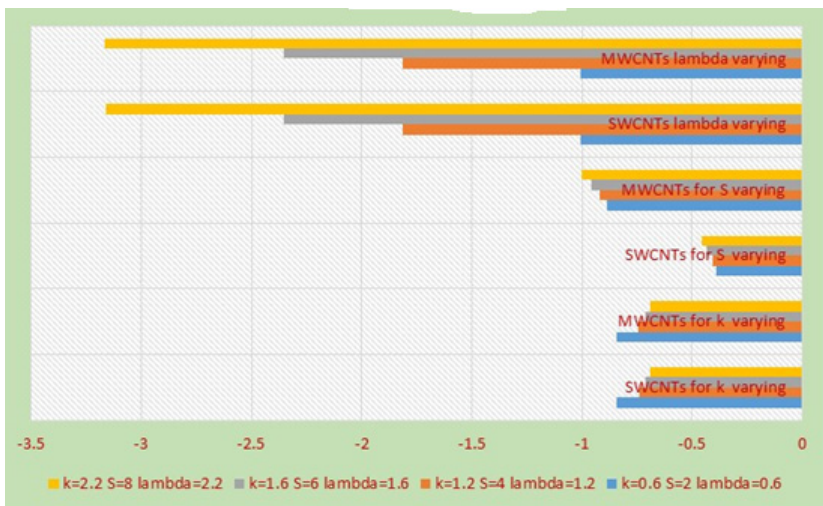
Figure 12. The behavior of shear stresses for multiple values of k, S, and λ .